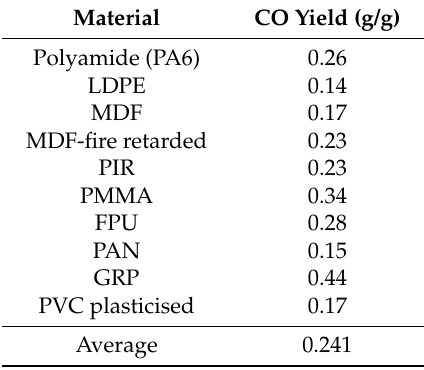
Table 6. CO yields in the SSTF simulating a post-flashover combustion furnace temperature of 850 ◦ C Φ =